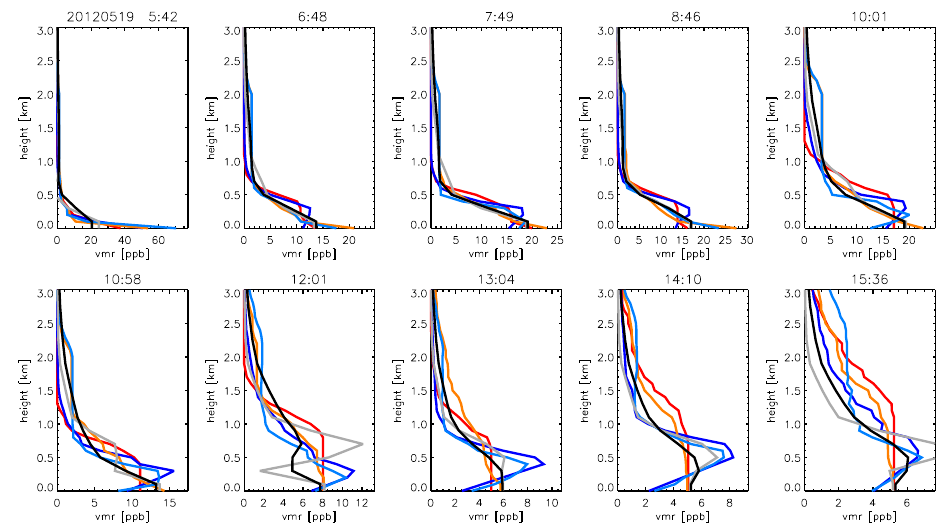
Figure 6. Examples of NO 2 profiles retrieved with method A – grey ( H s = 0 . 5km) and black ( H s = 1 . 5km) – and method B – parameteri- zations B1–B4 (see Fig. 1 and Table 2) shown in red, blue, orange and light blue